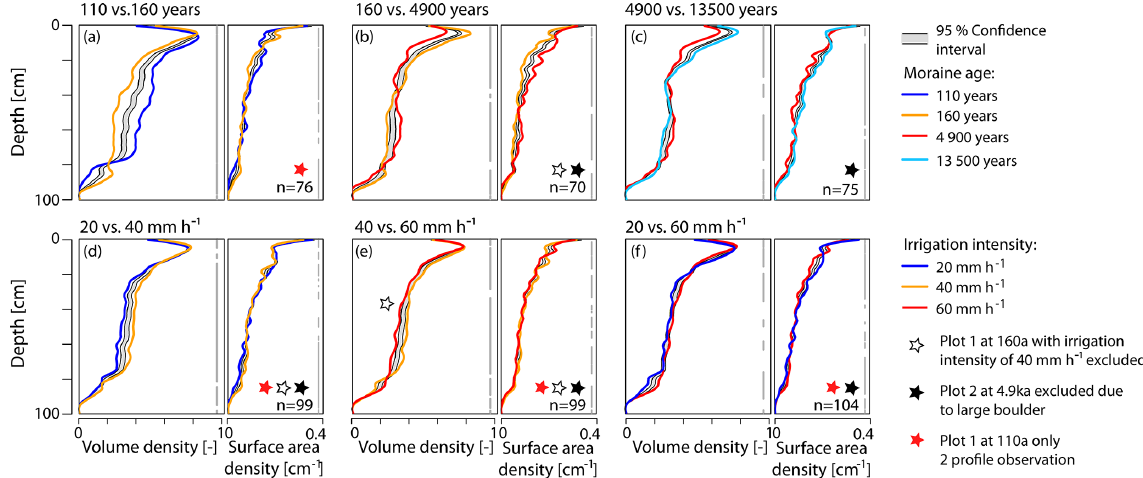
Figure 7. Differences in volume density and surface area density profiles with respect to (a–c) moraine age and (d–f) irrigation intensity. If the profile lines sit outside the gray-shaded confidence interval, the two profiles are considered to be significantly different. The parts of the depth profiles where this is the case are indicated by gray vertical bars on the right of each plot; n denotes the number of profiles used for the depth-wise re-sampling.